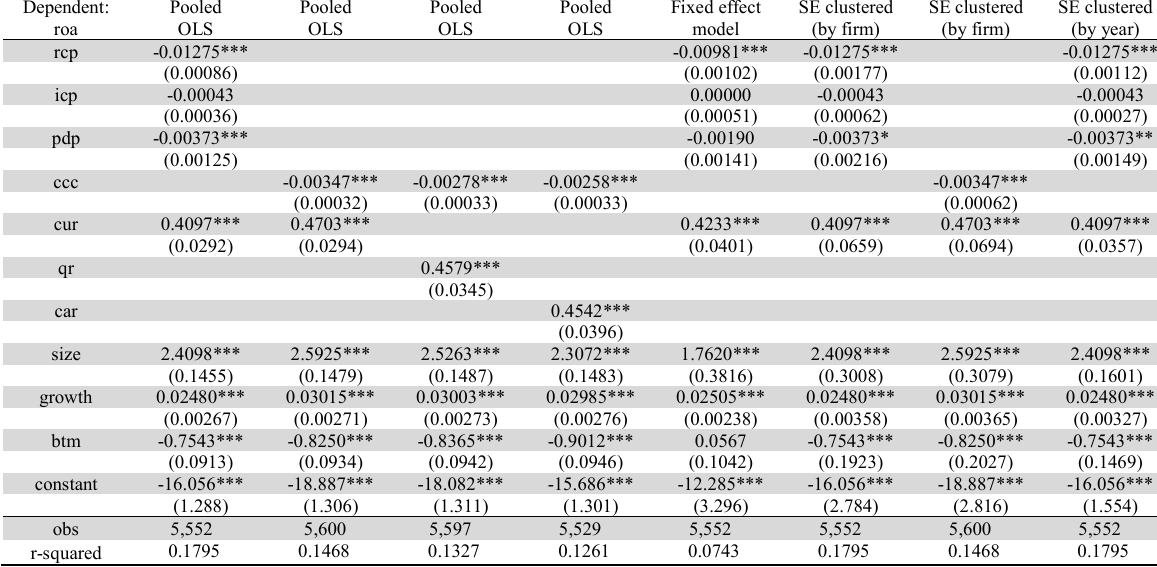
Impact of working capital management on return on assets (roa) Dependent: